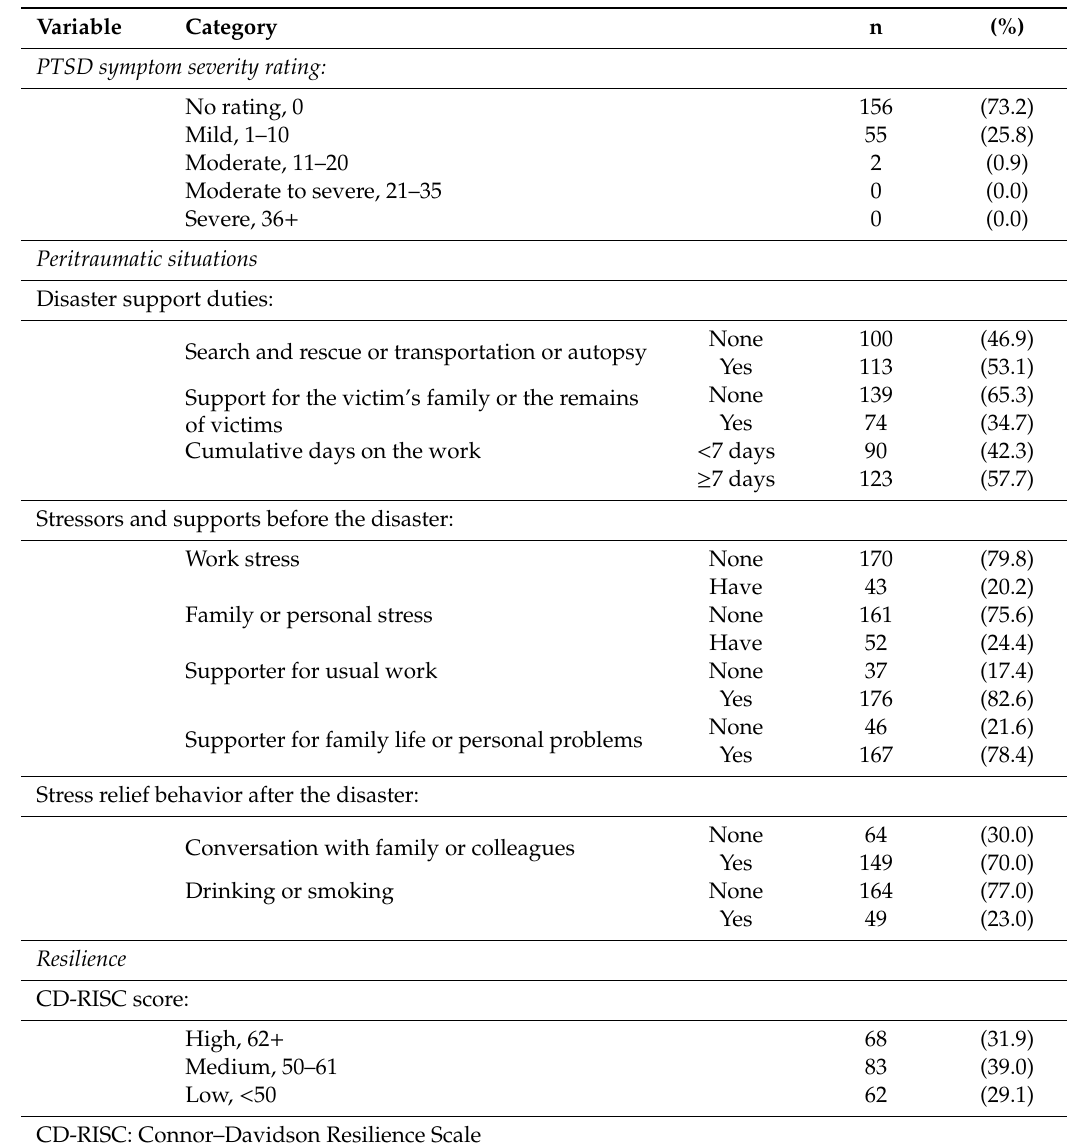
Table 1. Characteristics of the participants (n =